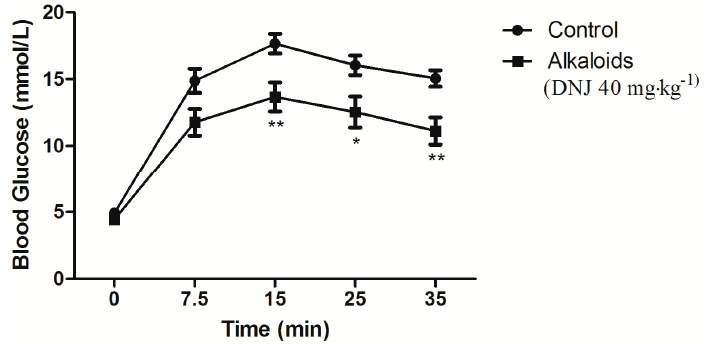
Figure A1. Effect of alkaloids (DNJ 40 mg·kg − 1 ) isolated from Mulberry leaves on glucose tolerance